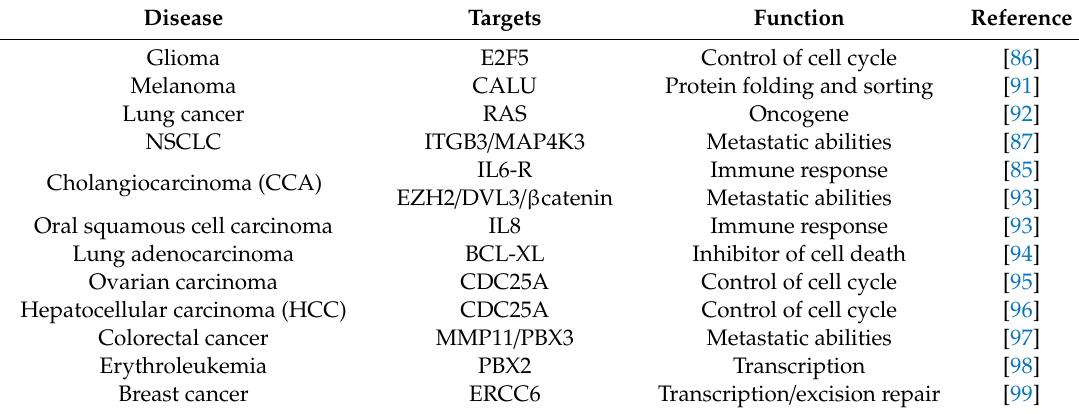
Table 3. Let-7c target genes described in cancer